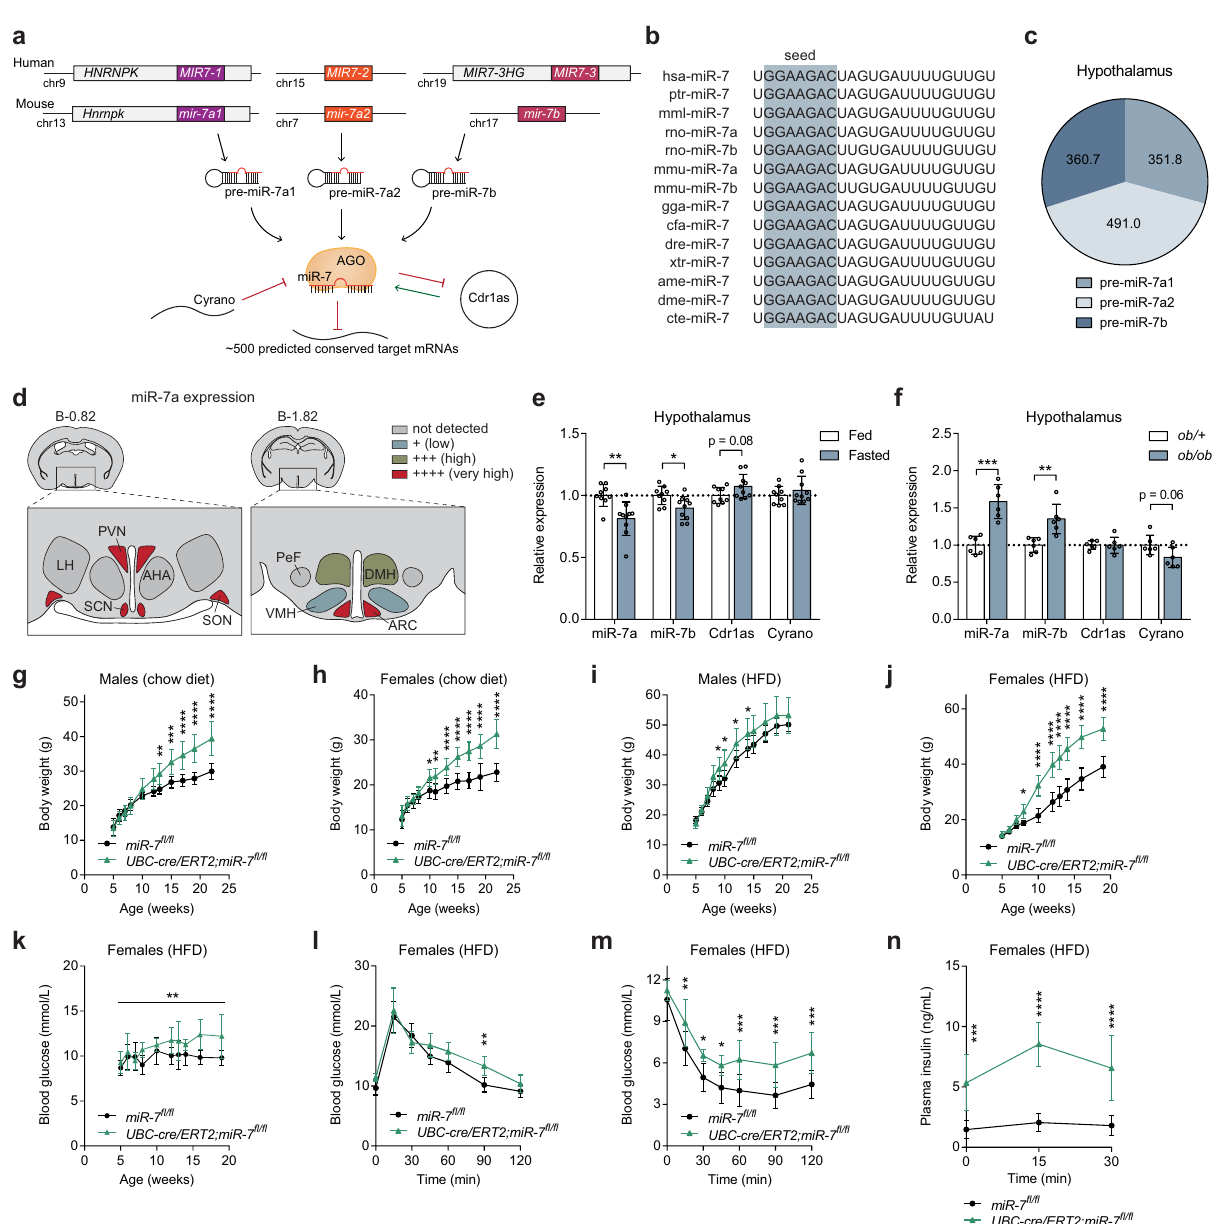
Fig. 1 | Severe obesity in mice lacking miR-7. a miR-7 genomic loci and organi- sation of the neuronal regulatory network comprising Cyrano, Cdr1as, and miR-7. Primary miRNA transcripts are processed into precursor miRNA (pre-miR), and then into mature miRNA (miR), which is loaded onto an AGO protein to interact with miRNA binding sites. b miR-7 sequences in different species. The grey box indicatesthe seed sequence. hsa, Homosapiens ; ptr, Pantroglodytes ; mml, Macaca mulatta ; rno, Rattus norvegicus ; mmu, Mus musculus ; gga, Gallus gallus ; cfa, Canis familiaris ; dre, Danio rerio ; xtr, Xenopus tropicalis ; ame, Apis mellifera ; dme, Dro- sophila melanogaster ; cte, Capitella teleta . c Contribution of each miR-7 precursor totheabsoluteexpressionofmiR-7inthehypothalamus.Valuesindicatecopies/pg RNA. d miR-7 expression in hypothalamic nuclei, based on published data 33 . AHA anterior hypothalamic area, ARC arcuate nucleus, DMH dorsomedial hypothala- mus, LH lateral hypothalamus, PeF perifornical nucleus, PVN paraventricular nucleus, SCN suprachiasmatic nucleus, SON supraoptic nucleus, VMH age (Fig. 2r), prior to any changes in body weight (Fig. 2c). This